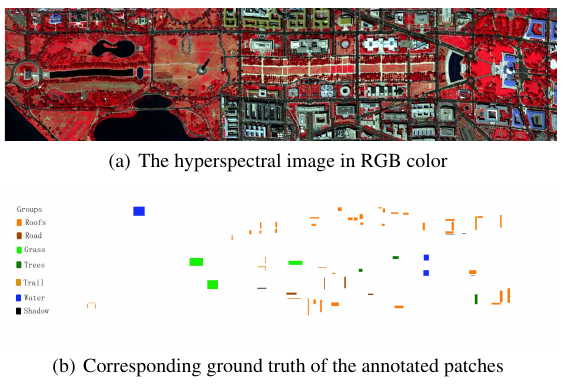
Figure 2: Washington DC Mall hyperspectral image (II) The AVIRIS Indian Pines hyperspectral dataset (Biehl, 2011) is a section of a scene taken over northwest Indiana’s Indian Pines( 145 × 145 pixels, 220 bands) by the Airborne Visible/Infrared Imag- ing Spectrometer(AVIRIS) sensor in 1992. Fig. 2(a) shows the AVIRIS Indian Pine image in RGB color, and the ground truth